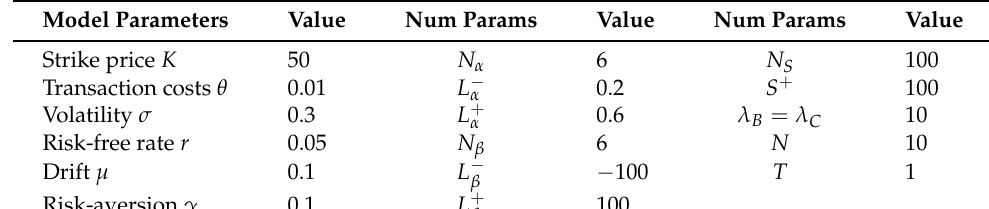
Table 2. Model and numerical parameters of the numerical solution.